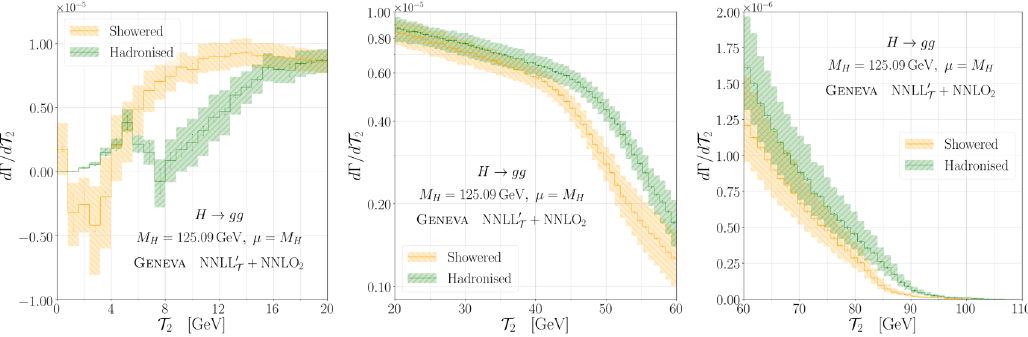
Figure 8. Comparison of the showered and hadronised T 2 spectra in Geneva for H ! gg